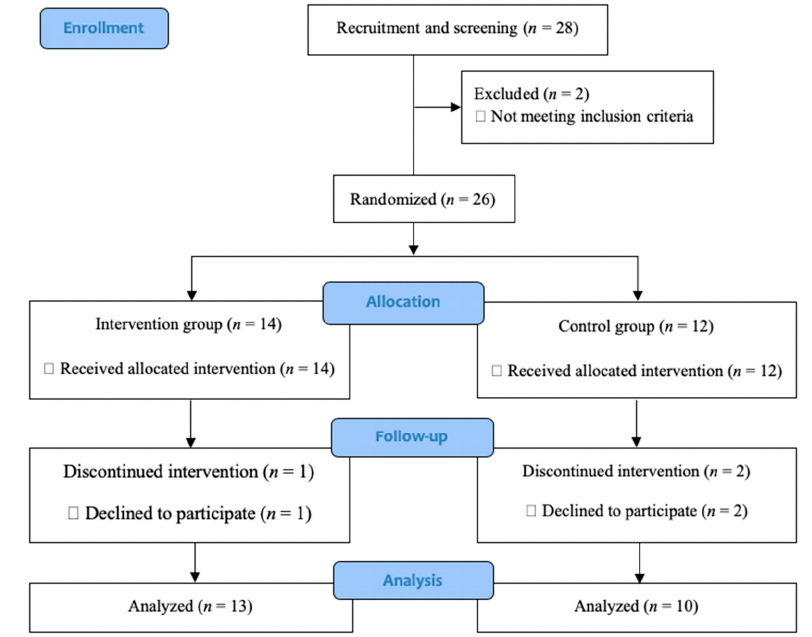
Figure 1. Consolidated standards of reporting trial (CONSORT) diagram.